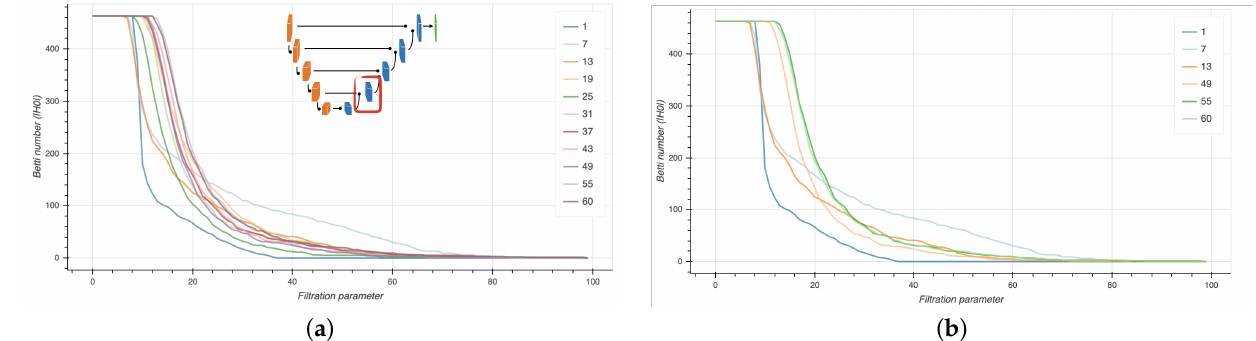
Figure 16. Betti curves for the 0-th homology group H0 from the third decoder block (inset) at different epochs ( a ) and in particular for the first and last three epochs ( b ).